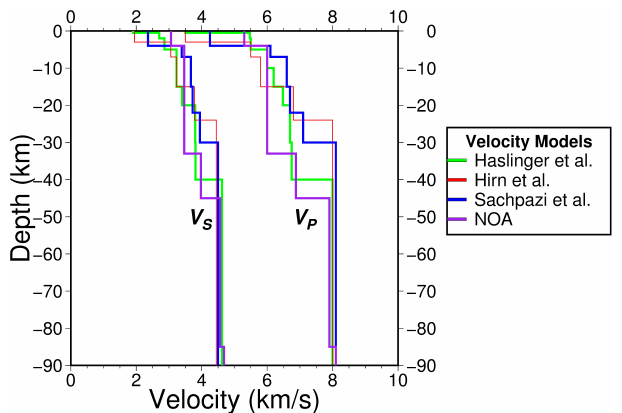
Figure 3. The seismic P - and S -wave velocity models tested for the relocation of the aftershock sequence. Green, blue, and red corre- spond to velocity models proposed by Haslinger et al. (1999), Sach- pazi et al. (2000), and Hirn et al. (1996), respectively. The model routinely used by NOAGI is marked in purple. The S -wave model of NOAGI is based on a constant V p /V s = 1 . 73. For Hirn et al. (1996) and Sachpazi et al. (2000), a constant V p /V s ratio of 1.80 was used as proposed by previous studies (Hatzfeld et al., 1995; Le Meur et al., 1997; see also Haslinger et al., 1999). Haslinger et al. (1999) provide a separate velocity